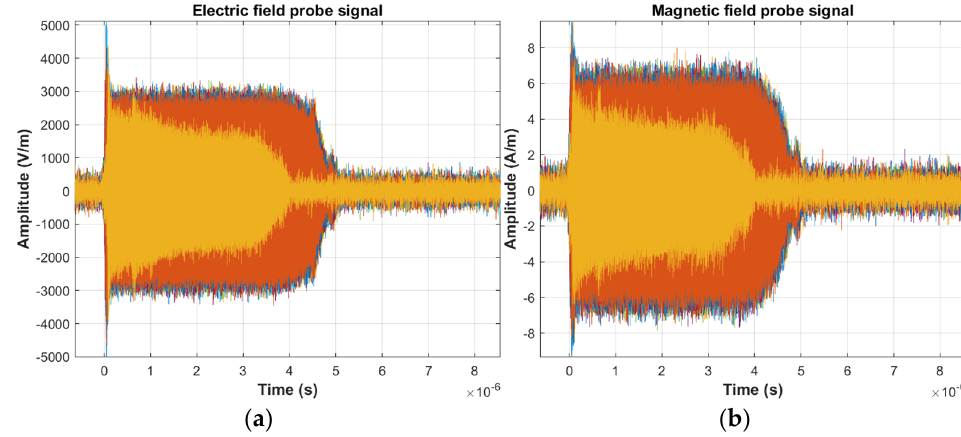
Figure 16. Measurement results for the electric ( a ) and magnetic ( b ) fields measurement records in the outdoor tests.